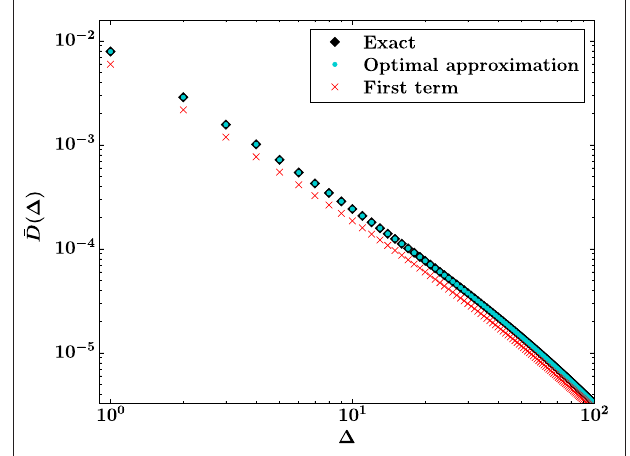
FIGURE 2 | Optimal approximation from Equation (44) with 13 available terms (turquoise) and exact result (black) for the burst distribution. The first term of the asymptotic series (red), which is Equation (4), is shown for comparison. The threshold distribution is a Weibull distribution with k